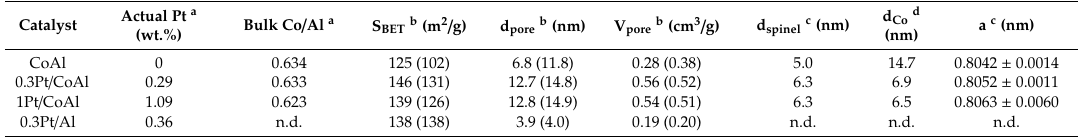
Table 1. Physico-chemical properties of the